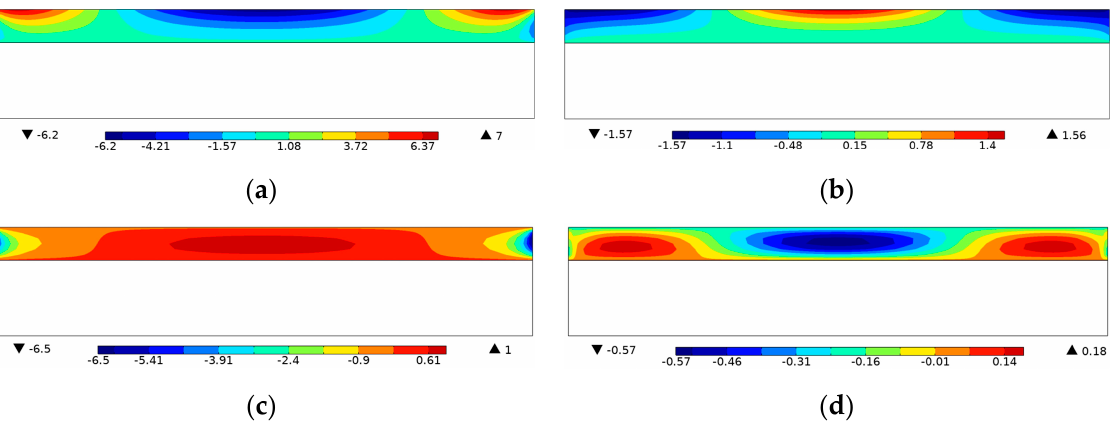
Figure 3. Influence of the equipotential boundary conditions on voltage contour. ( a ) Without equipotential constraint f = 4 kHz; ( b ) without equipotential constraint f = 16 kHz; ( c ) with equipotential constraint f = 4 kHz; ( d ) with equipotential constraint f = 16 kHz.